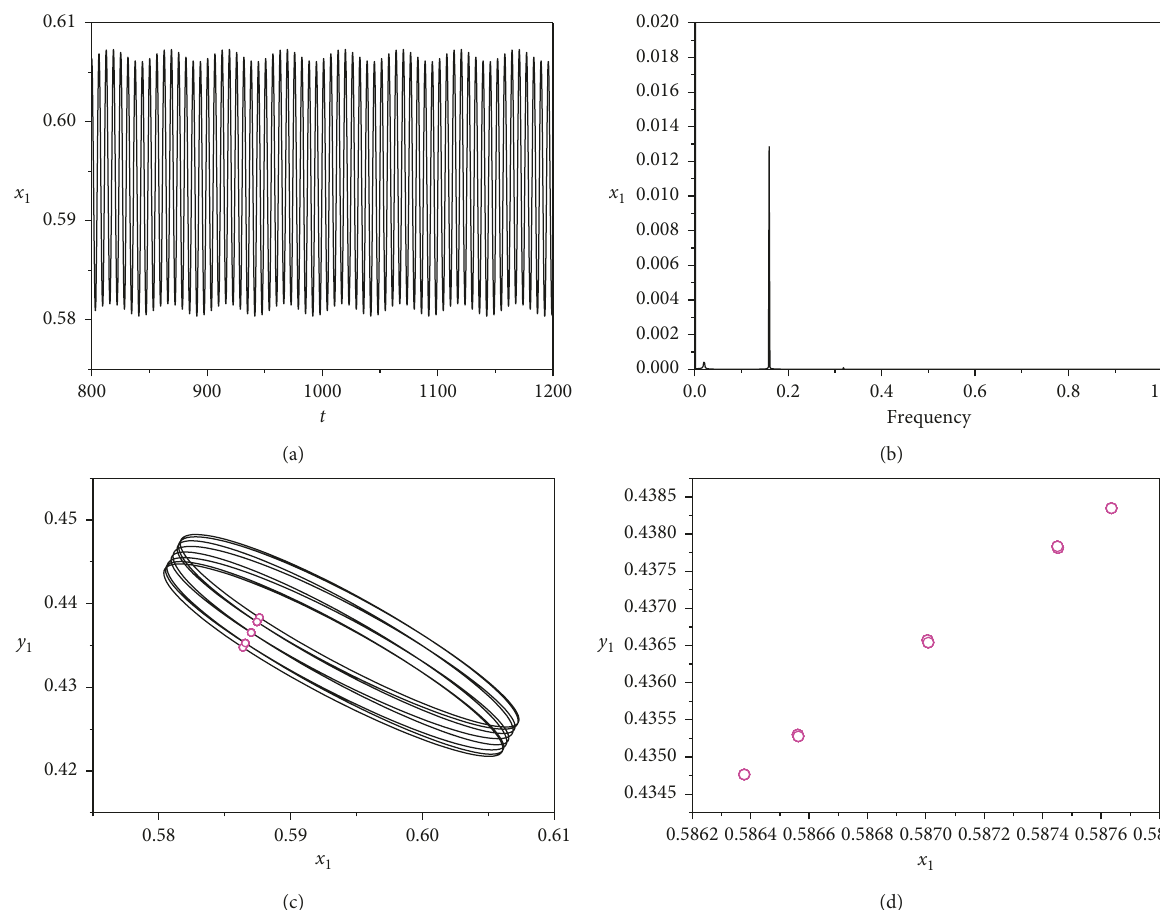
Figure 5: ω � 2.25: (a) displacement response; (b) frequency spectrum; (c) rotor orbit; (d) Poincar´e